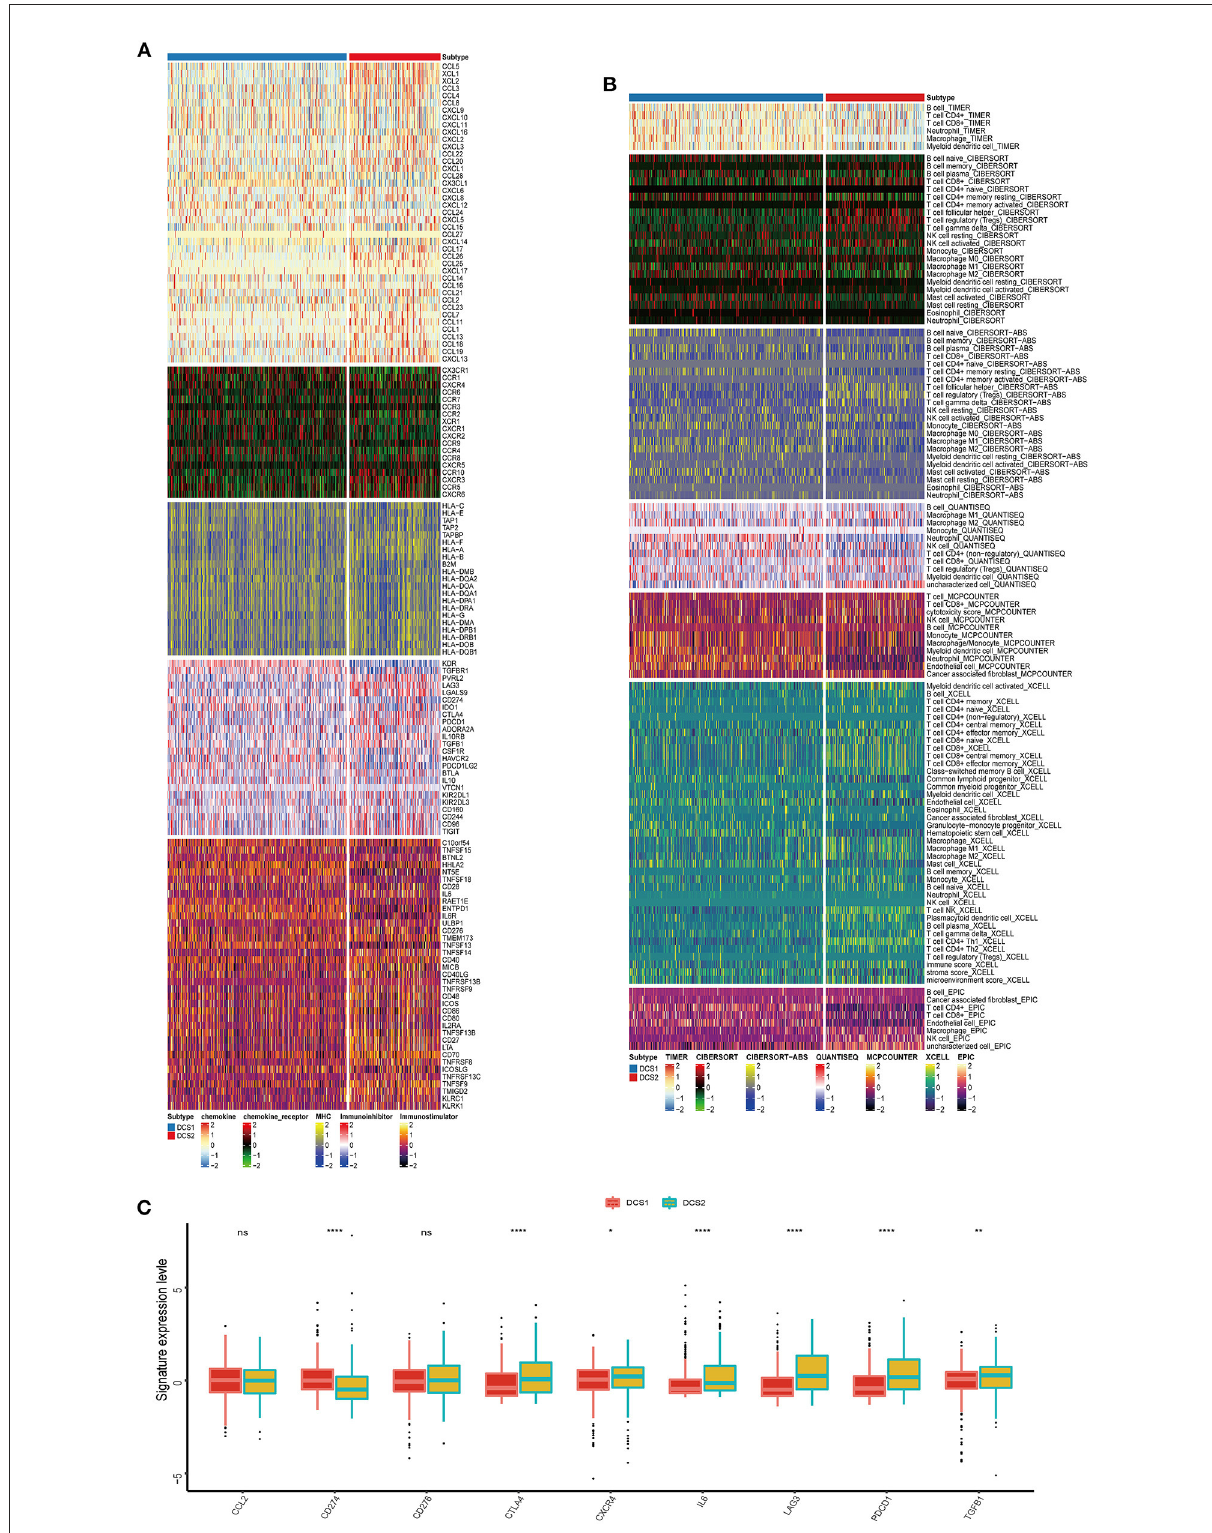
FIGURE3 Immune profiling between subtypes. (A,B) Heatmap indicating the different immune signatures and immune component enrichment between subtypes. (C) Different expression level of immune checkpoint inhibitors between subtypes.